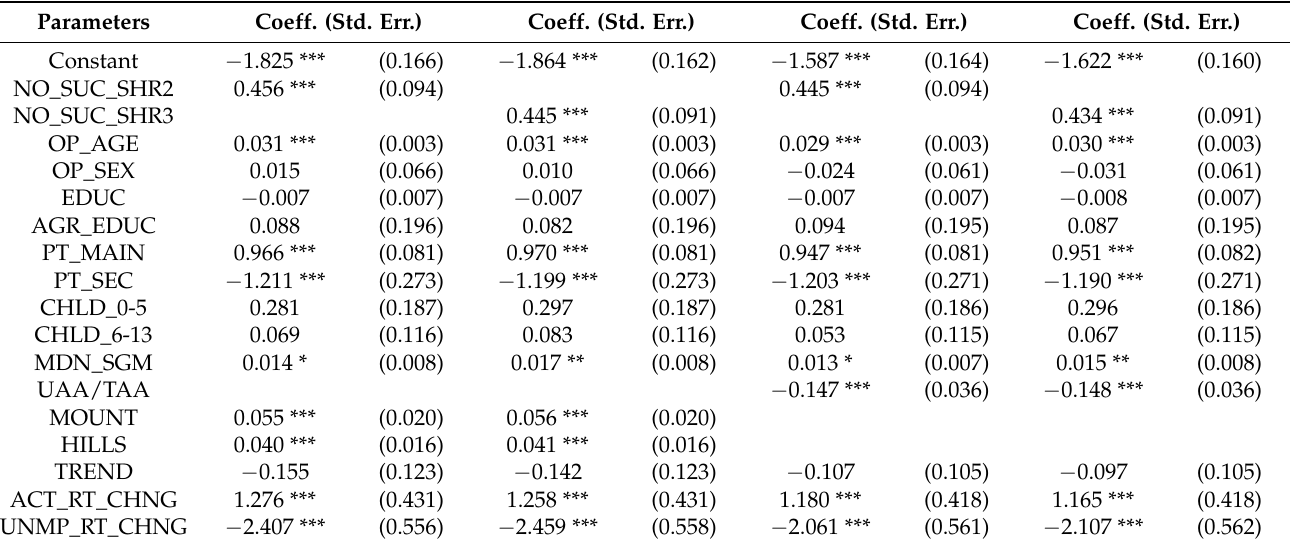
Table A5. Parameter estimates of different number of farms decrease rate models using the family farms database. Parameters